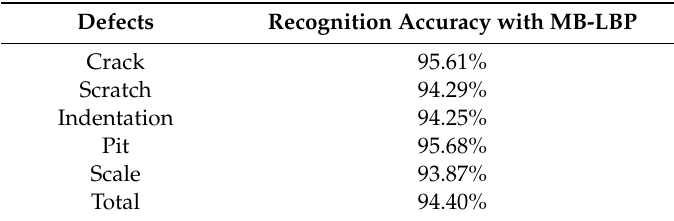
Table 3. Recognition accuracy of each class of defects with the MB-LBP.